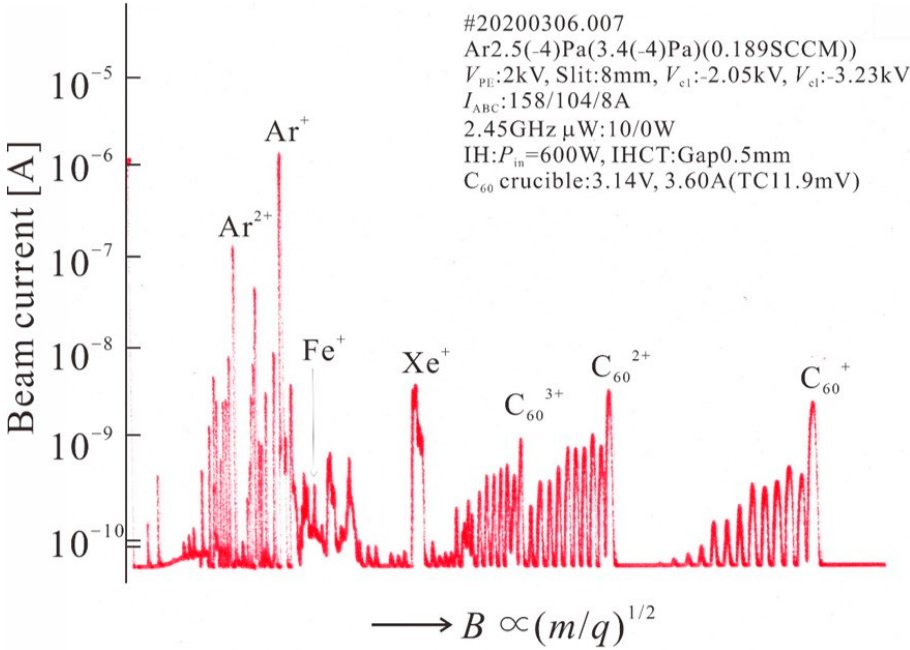
Figure 3. Typical coexistence spectrum of iron and fullerene ion (log amplifier).